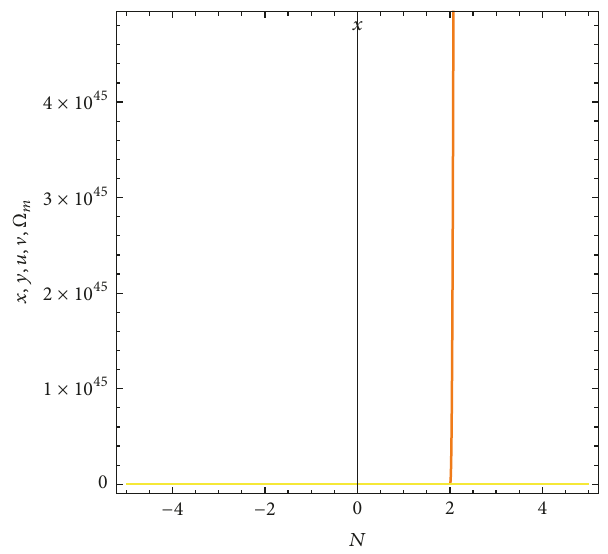
Figure 2: Plot of ( 2 ) variations of 𝑥 (blue), 𝑦 (green), 𝑢 (orange), V (red), and Ω 푚 (yellow) versus 𝑁 near 𝑃 2 , for 𝛾 = 1 , 𝛿 = 0.5 , and 𝜆 = −0.5 . The position corresponding to 𝑁 = 0 is the fixed point under consideration.